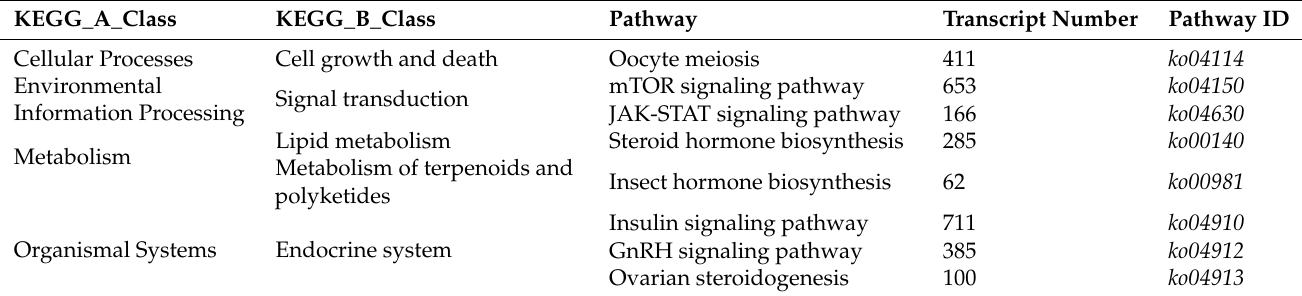
Table 3. The reproduction-related pathways in which some of the putative target transcripts of the eight validated ovary- or testis-biased miRNAs